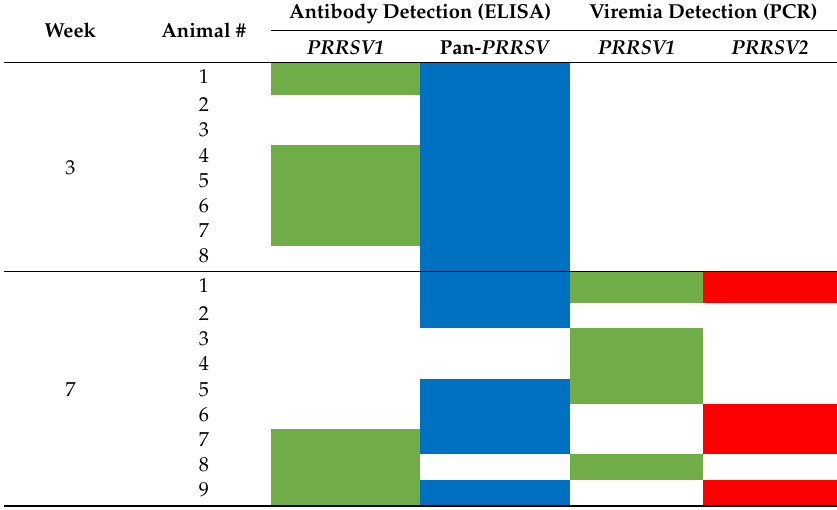
Figure 2. Anti- PRRSV1 (green) and pan- PRRSV (blue) antibody detection. Table 1. Antibody detection. Detection of antibodies to PRRSV1 (positive samples highlighted in green), antibodies to both, PRRSV1 and PRRSV2 (positive samples highlighted in blue), RNA from PRRSV1 (positive samples highlighted in green), and RNA from PRRSV2 (positive samples highlighted in red). Animal